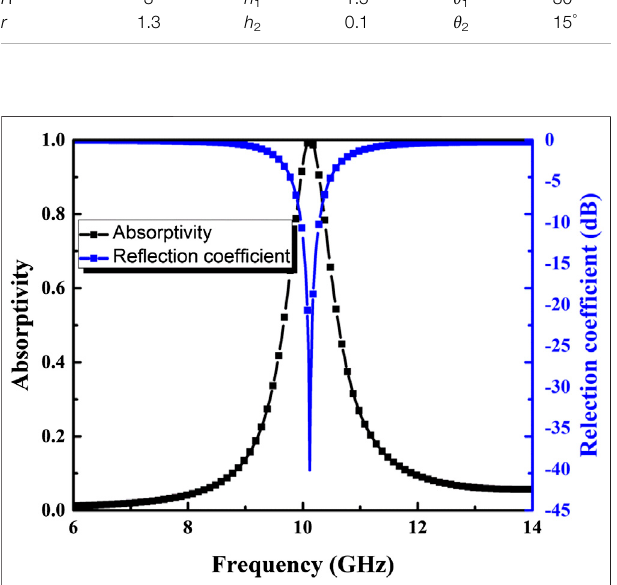
FIGURE 2 | Absorption and re fl ection spectrum of the proposed MA under normal